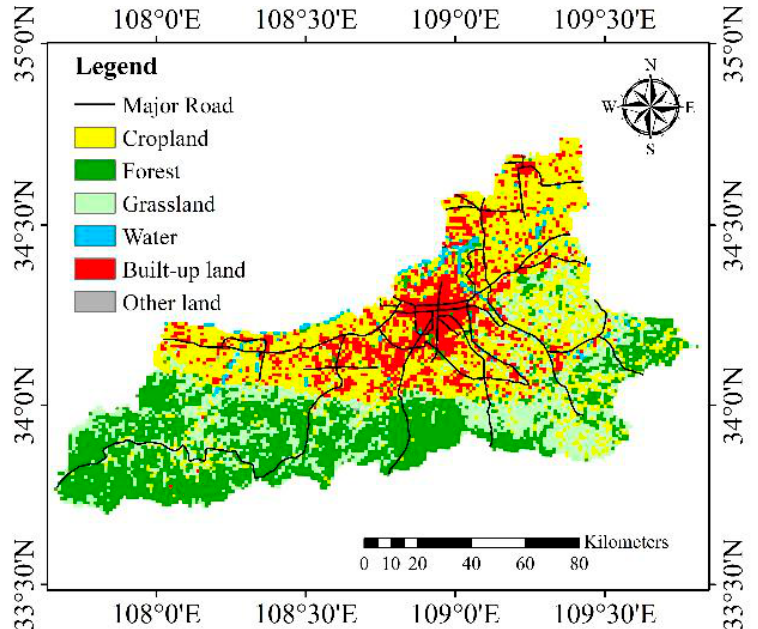
Figure 5. Simulation result of the land use cover change in 2030